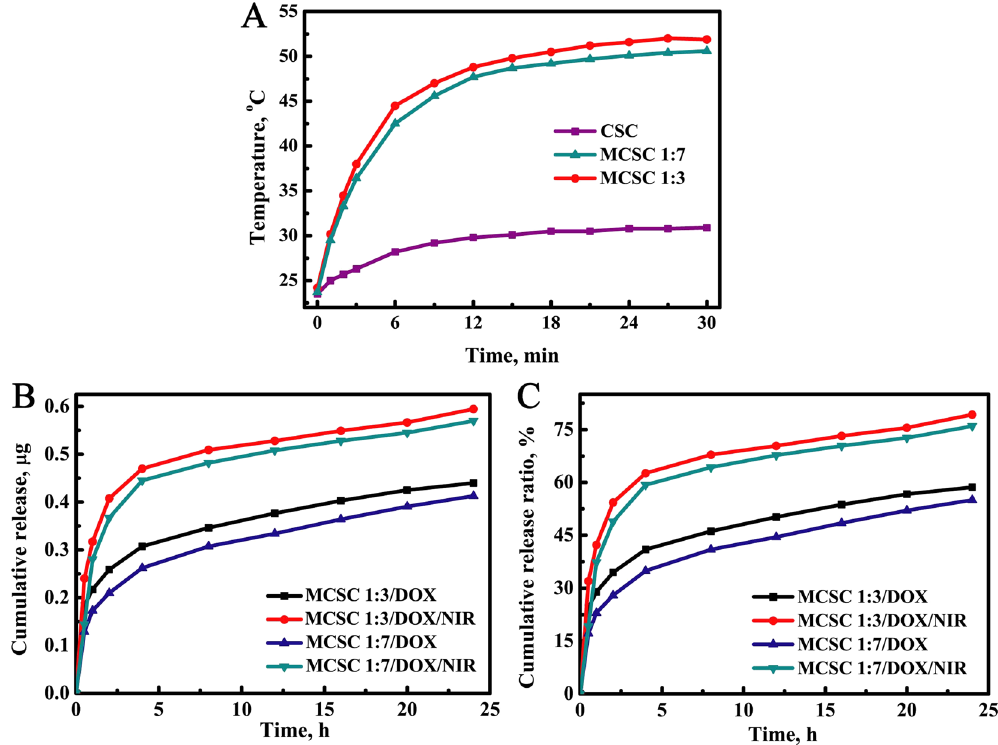
Figure 5. Photothermal conversion efficiency and drug release profiles of scaffolds. ( A ) Temperatures changes post the irradiation of NIR laser for CSC, MCSC 1:7 and MCSC 1:3 scaffolds. ( B ) In vitro drug cumulative release amounts and ( C ) cumulative release ratios from MCSC 1:7/DOX and MCSC 1:3/DOX scaffolds in the presence or absence of NIR irradiation. NIR, near